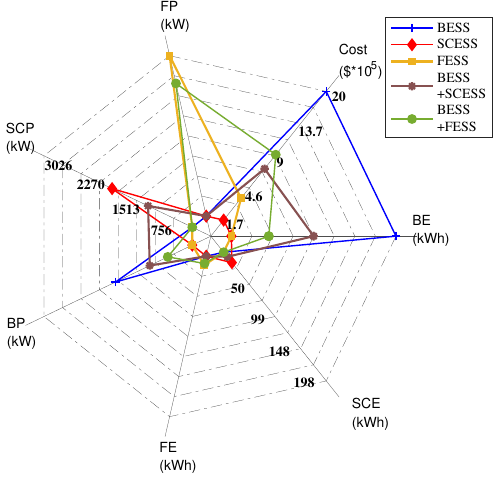
Figure 11. Comparison of different combinations of ESS for 45% regenerative energy saving, where BE: Battery Energy, BP: Battery Power, SCE: SC Energy, SCP: SC Power, FE: Flywheel Energy, FP: Flywheel Power. The axes for energy are scaled from 0–198 kWh that for power are scaled from 0–3026 kW, and the axis for cost is scaled from $1.68 × 10 5 –20 × 10 5